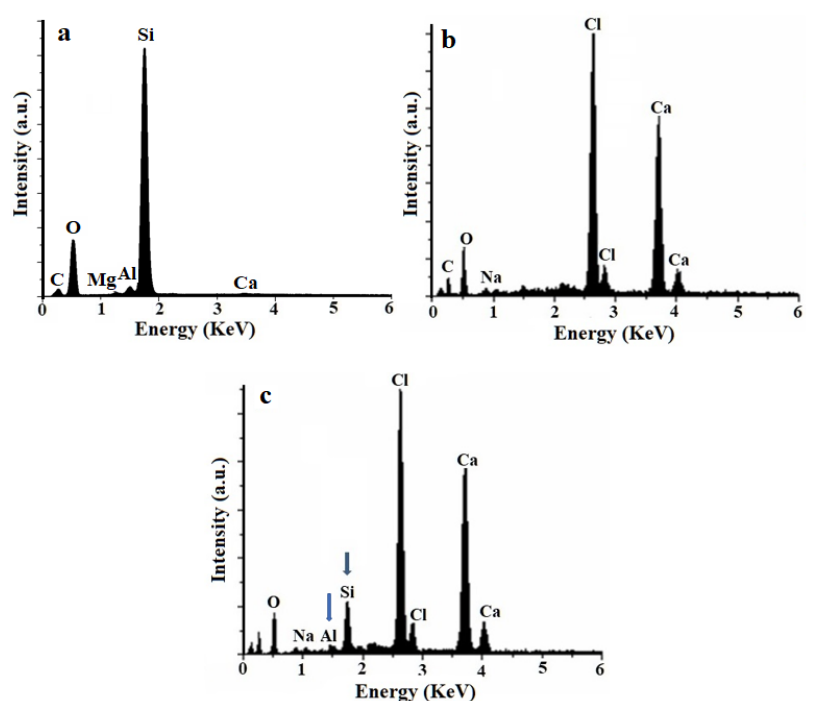
Figure 6. EDAX spectra for: ( a ) PCHs, ( b ) Neat NaAlg beads, and ( c ) hybrid materials NaAlg-PCHs 10 wt%.